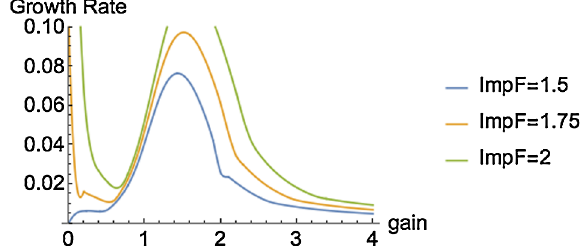
FIG. 22. Same as the previous figure, for selected